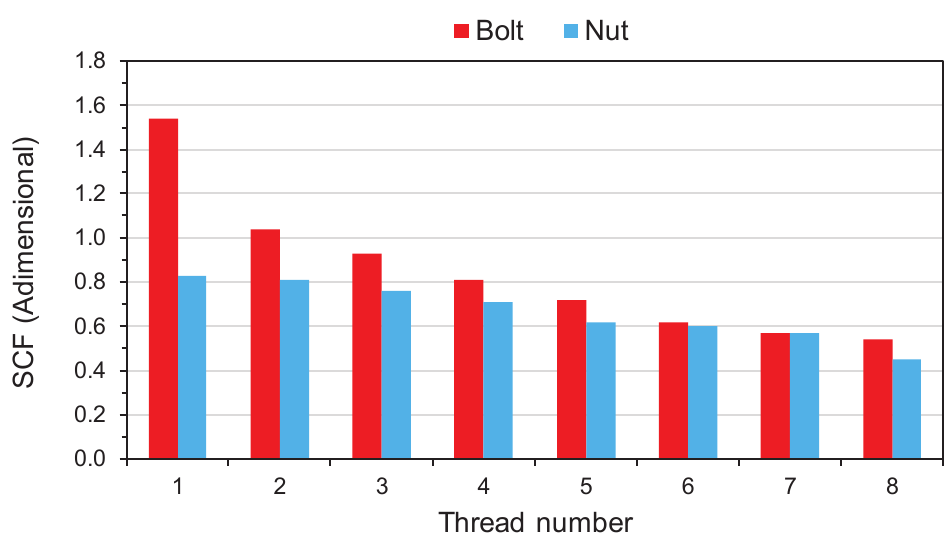
Figure 10. Stress concentration factor across the root of the bolt threads based on the average stress values.